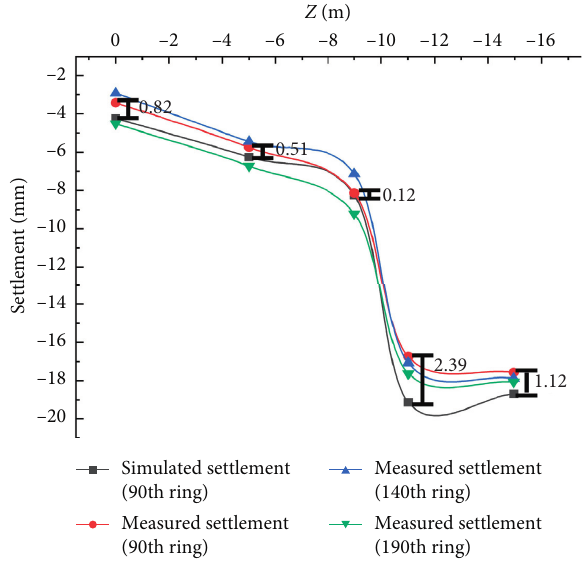
Figure 10: Comparison of